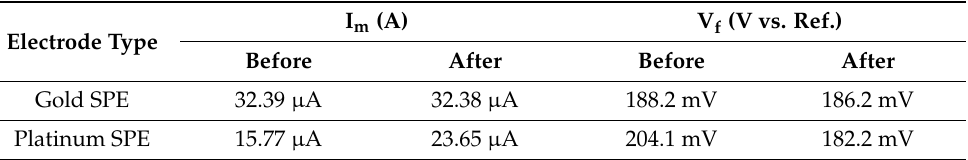
Table 1. Electrochemical measurements before and after exposure to acetone .